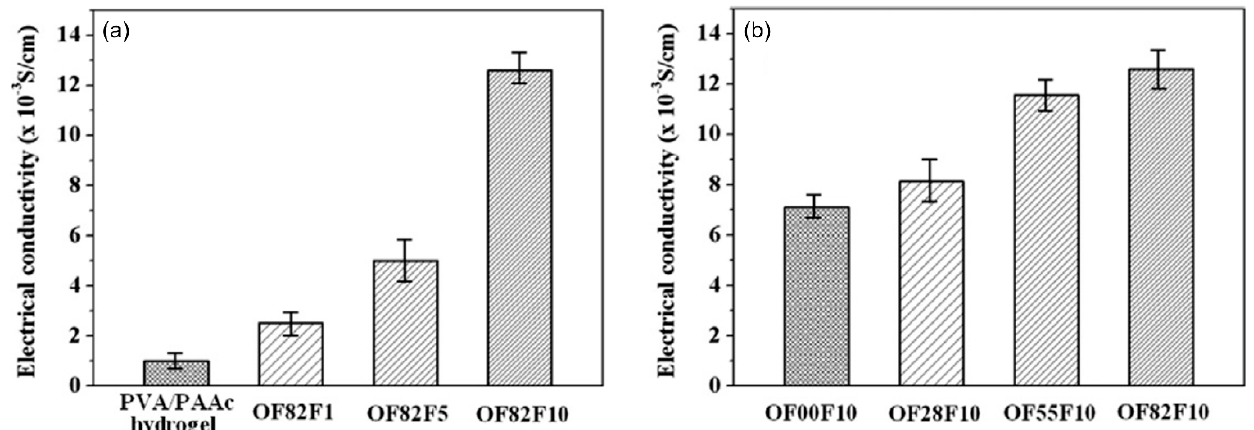
Figure 15. Variations in electrical conductivity of nanofibers depending on ( a ) content of oxyfluorinated MWCNTs and ( b ) oxyfluorination condition for MWCNTs. Reproduced with permission from [102], Copyright © 2021, Elsevier.